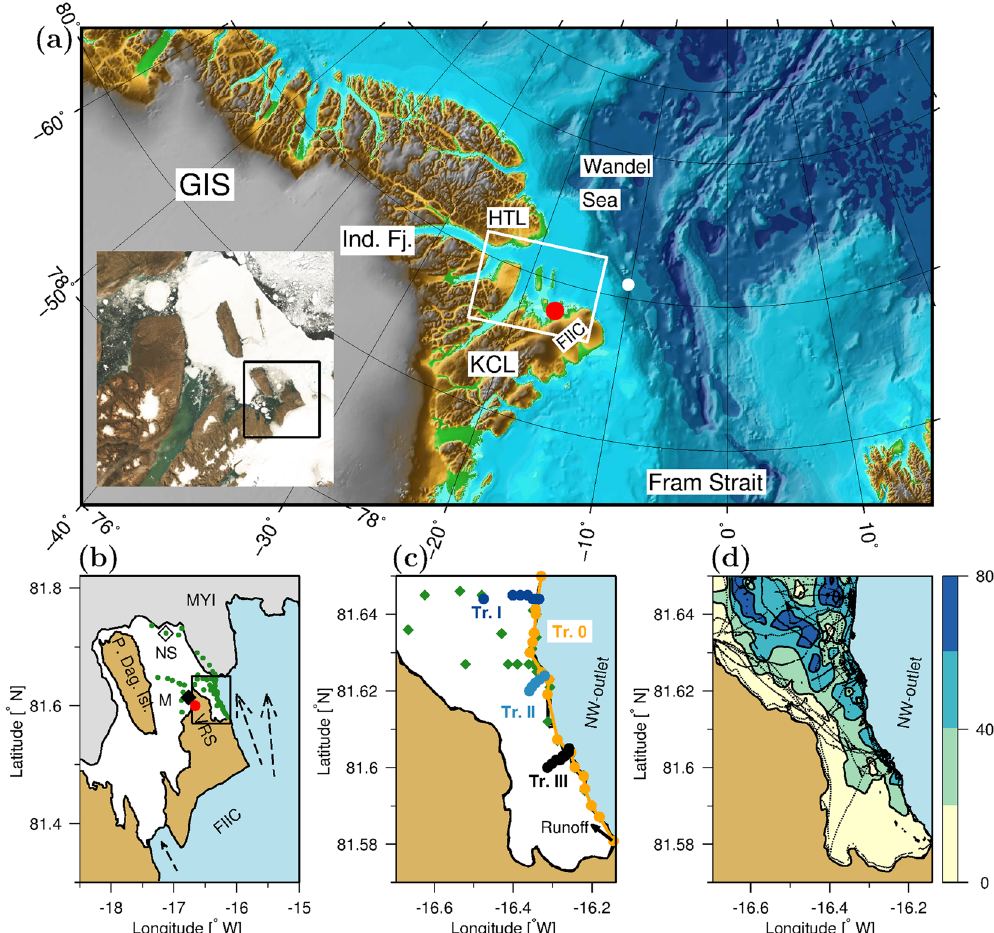
Figure 1. Study area and station map. ( a ) Northeastern Greenland and the Greenland Ice Sheet (GIS), Independence Fjord (Ind. Fj.) and Herluf Trolle Land (HTL), north of the fjord system, the peninsula Kronprins Christian Land where the Villum Research Station (VRS) is located (red bullet) next to Flade Isblink ice cap (FIIC). Station YK175 is marked on the shelf (white bullet). The map is based on data from IBCAO 43 and produced by the GMT 45 software. Landsat 8 satellite image from 12 August 2015 is shown in the inset (white rectangle). Landsat 8 data was compiled by the U.S. Geological Survey; Data processed by GDAL - Geospatial Data Abstraction Library: Version 1.10.1, Open Source Geospatial Foundation, http://gdal.osgeo.org). ( b ) Digitized satellite image (black rectangle shown on inset in ( a )) and CTD-stations (green symbols). The CTD- station NS (open diamond, 81°43.376 ′ N, 17°7.736 ′ W) located northwest of the terminus at the multi-year ice edge (MYI) and the CTD-mooring located at station M (black diamond) between Prinsesse Dagmar Island and VRS. Dashed arrows indicate glacier ice flow (QGIS was applied for digitizing, Quantum GIS Development Team (2015). Quantum GIS Geographic Information System. Open Source Geospatial Foundation Project. http://qgis.osgeo.org. The maps ( b – d ) were made by the scientific graphic language Gri, http://gri.sourceforge. net). ( c ) Station map along the terminus (black rectangle in panel b) with stations shown along transect 0 (orange), I (blue), II (light blue), III (black) and the remaining stations in the area (green diamonds) between the north-western glacier outlet (NW-outlet) and VRS. Runoff from a meltwater river along the glacier on land is indicated (black arrow). ( d ) Bathymetry (m) shown by contours and colors obtained from echo soundings (dotted